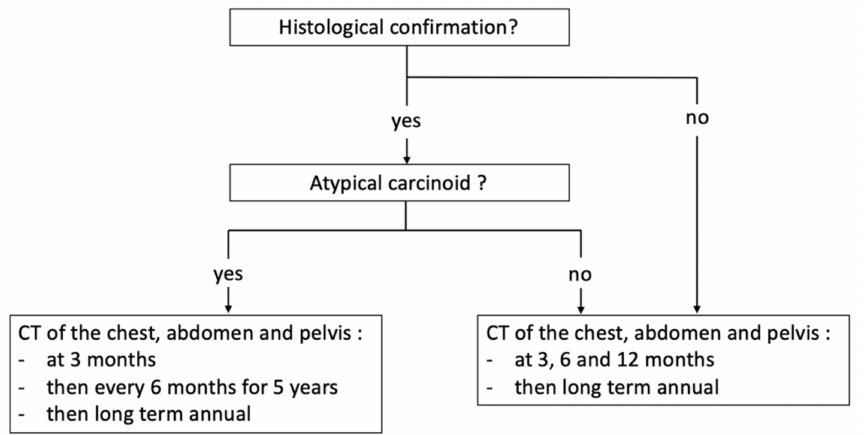
Figure 3. Proposal of follow-up recommendations for patients with